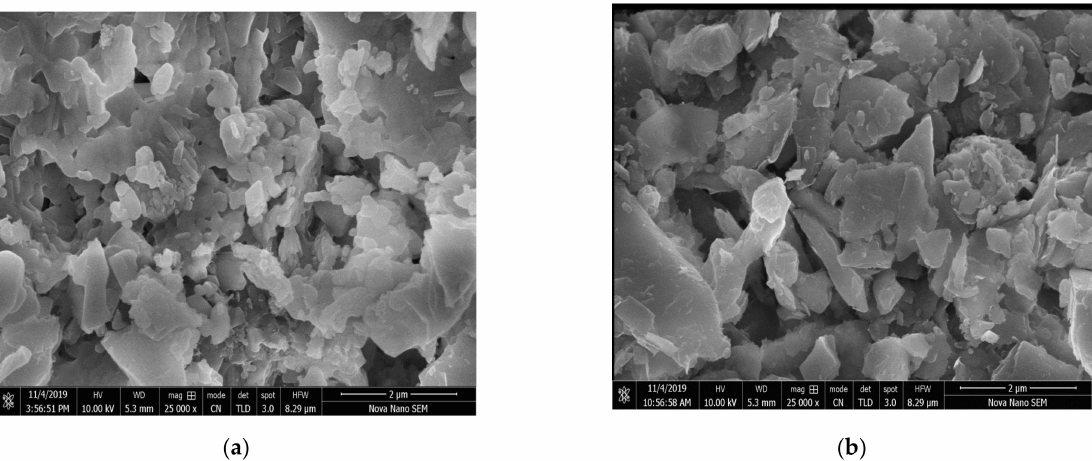
Figure 11. SEM images of ( a ) calcinized ( b ) non-calcinized composite of bentonite and sodium zeolite.